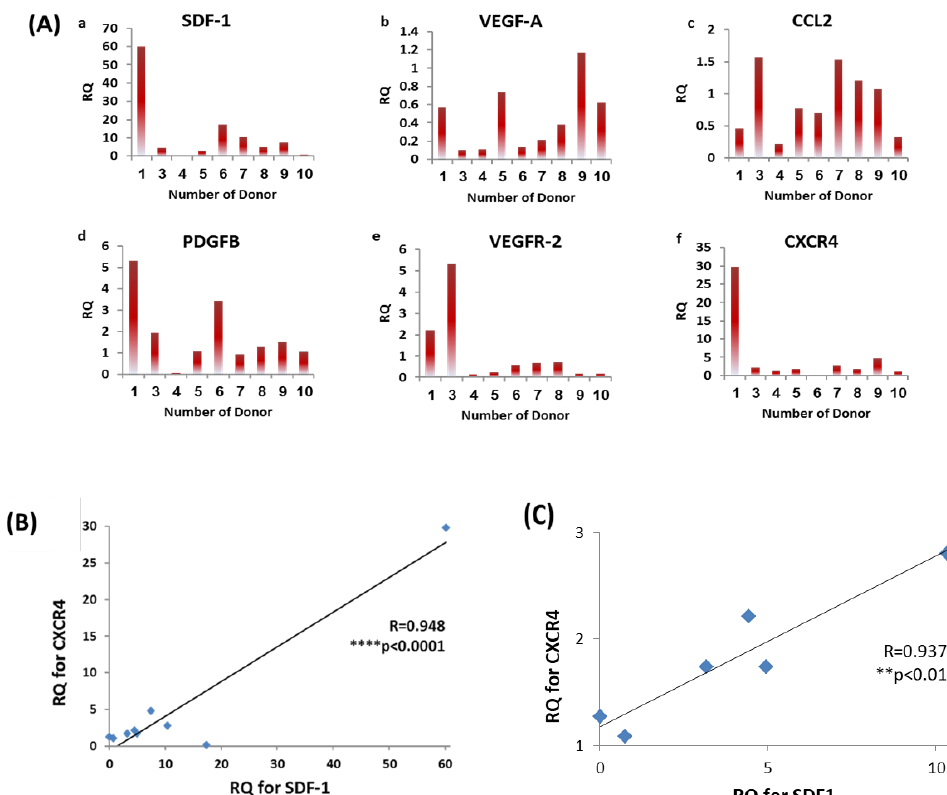
Figure 4. EPCs expression levels of angiogenic and chemoattractant genes. ( A ) mRNA expression of ( a ) SDF-1 ( b ) VEGF-A ( c ) CCL2 ( d ) PDGFB ( e ) VEGFR-2 ( f ) CXCR4 genes. RQ values were normalized to donor 2. ( B ) Positive correlation between SDF-1 and CXCR4 expression levels between all donors, R = 0.948 **** p < 0.0001( C ) and after excluding outlier results, R = 0.937 ** p < 0.01.